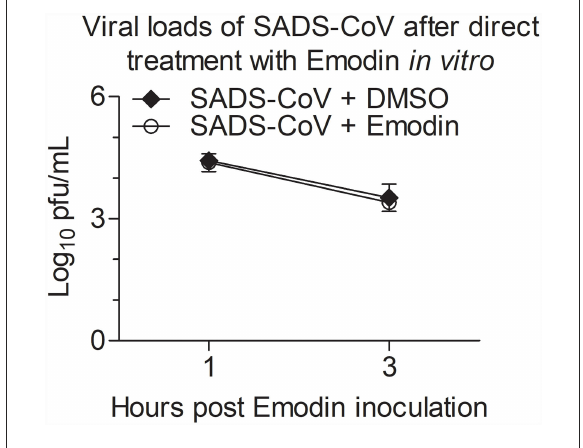
FIGURE3 Emodin cannot directly impair SADS-CoV infectivity. SADS-CoV was co-incubated with Emodin (12.5 µ g/ml) or 0.1% DMSO at 37 ◦ C for 1h or 3h, and then viral titers were determined in Vero cells with the TCID 50 assay. Results are representative of three independent experiments (mean ± SD). n = 3.